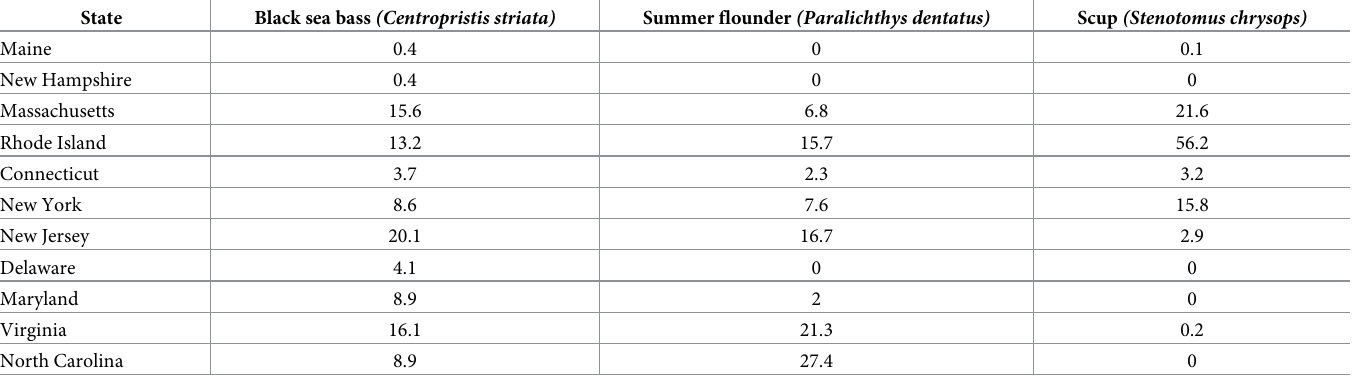
Table 1. State-wide commercial quota allocation for black sea bass ( Centropristis striata) , summer flounder ( Paralichthys dentatus ) and scup ( Stenotomus chrysops ) according to the Mid-Atlantic Fishery Management Council. Values shown as percentage of total quota. States ordered latitudinally from north to south. Note that sum- mer flounder quota for Maine, New Hampshire and Delaware is 0.05, 0.0005, and 0.02 percent,